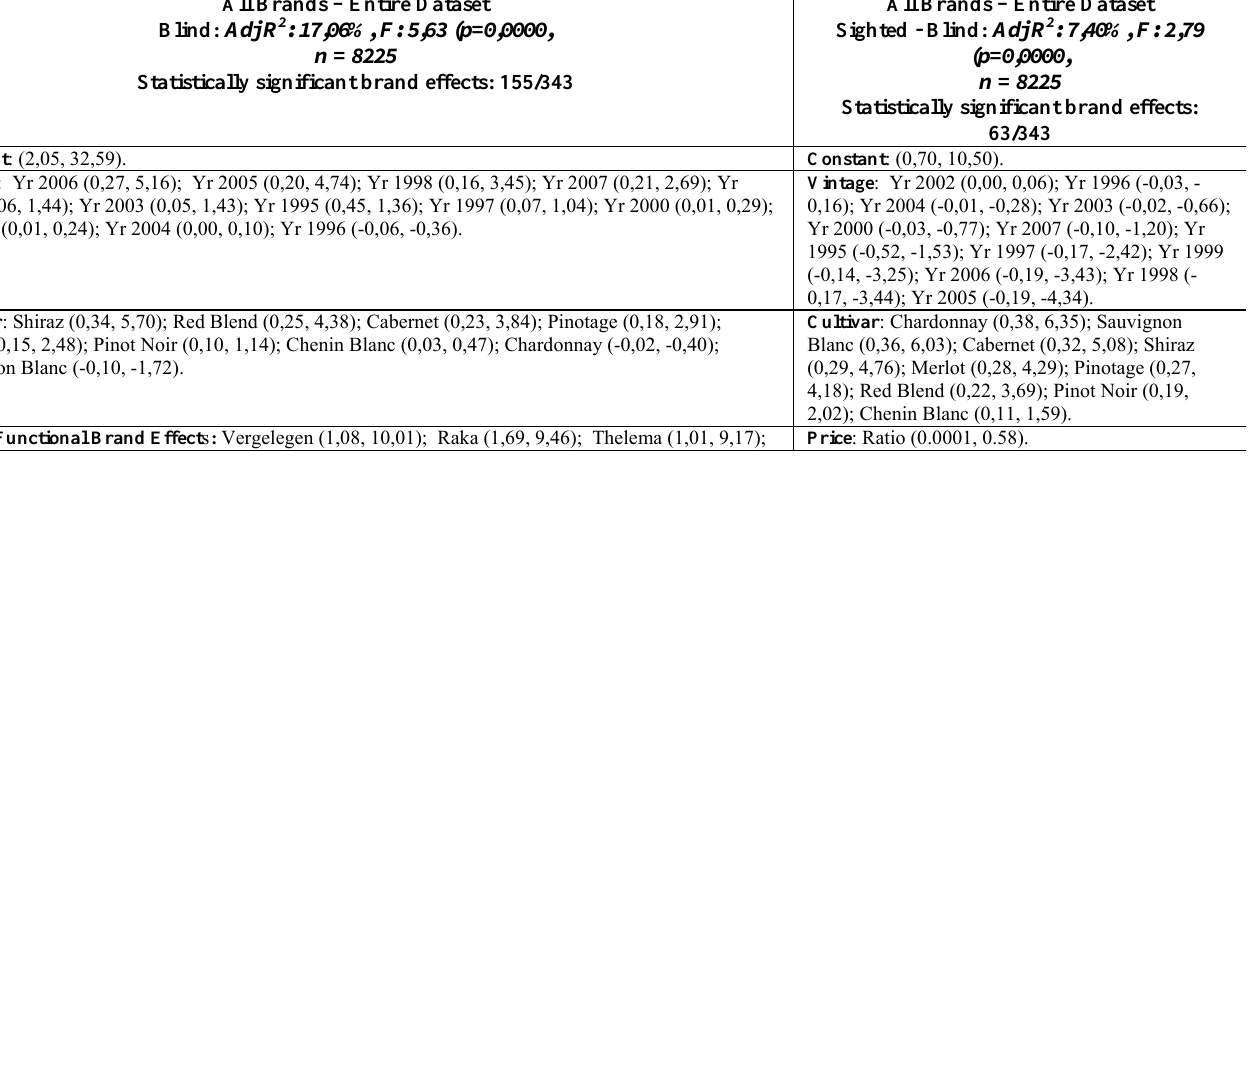
Table 14 : Estimated regression models explaining blind and sighted minus blind wine assessments for the entire dataset . Model variables appear (with their respective coefficients and significant t-stat figures in parenthesis) in the sequence: constant, vintage, cultivar, price, and brand. Each variable is sorted in order of statistical significance. All Brands – Entire